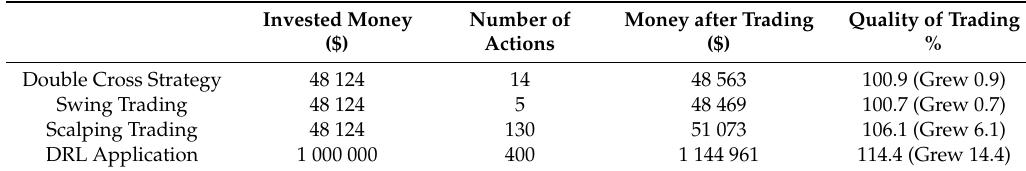
Table 4. Experiment results on Bitcoin’s data.